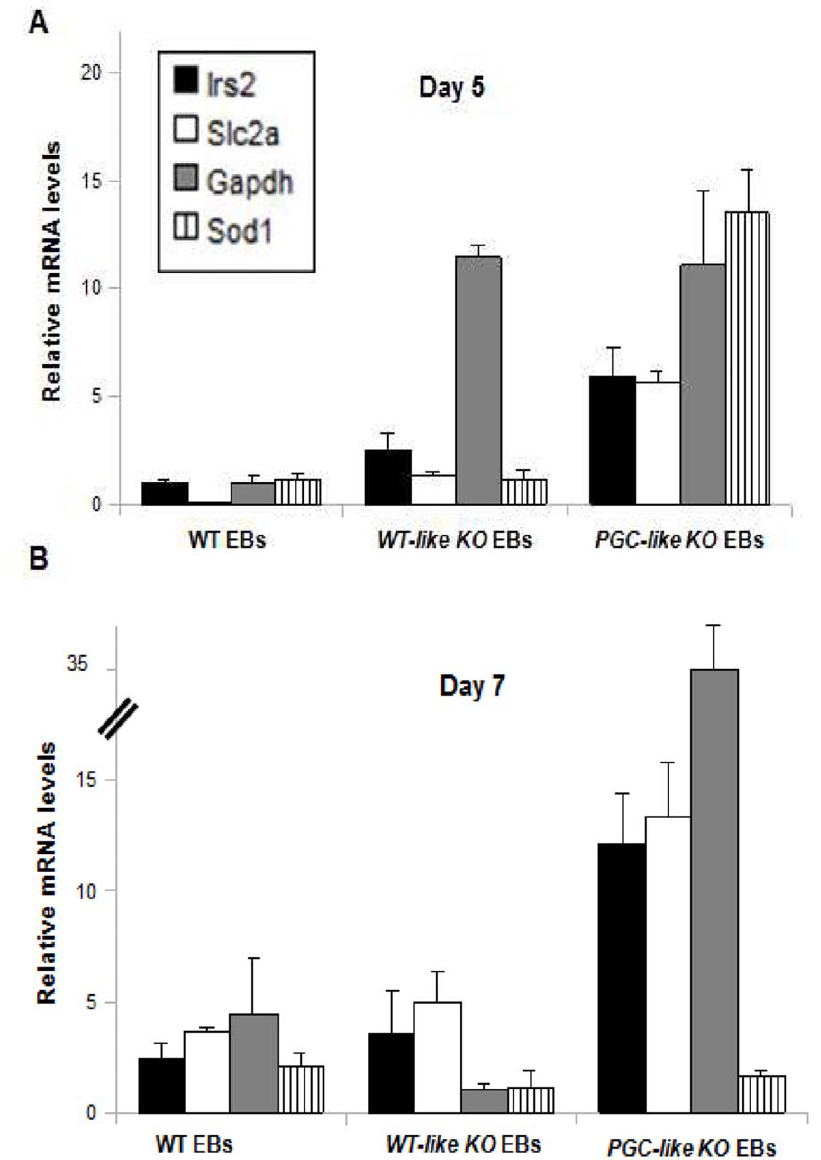
Figure 5. Metabolic transcription behaviour of the WT and Prnp -null cell lines. WT, WT-like KO EB and PGC-like KO EB mRNA expression patterns for Irs2 (Insulin Receptor Substrate 2), Slc2a (Glucose Transporter 1 - Glut1 -), Gapdh (Glyceraldehyde 3-phosphate Dehydrogenase) and Sod1 (Superoxide Dismutase 1) on Days 5 (A) and 7 (B). (Error bars, s.e.m.).